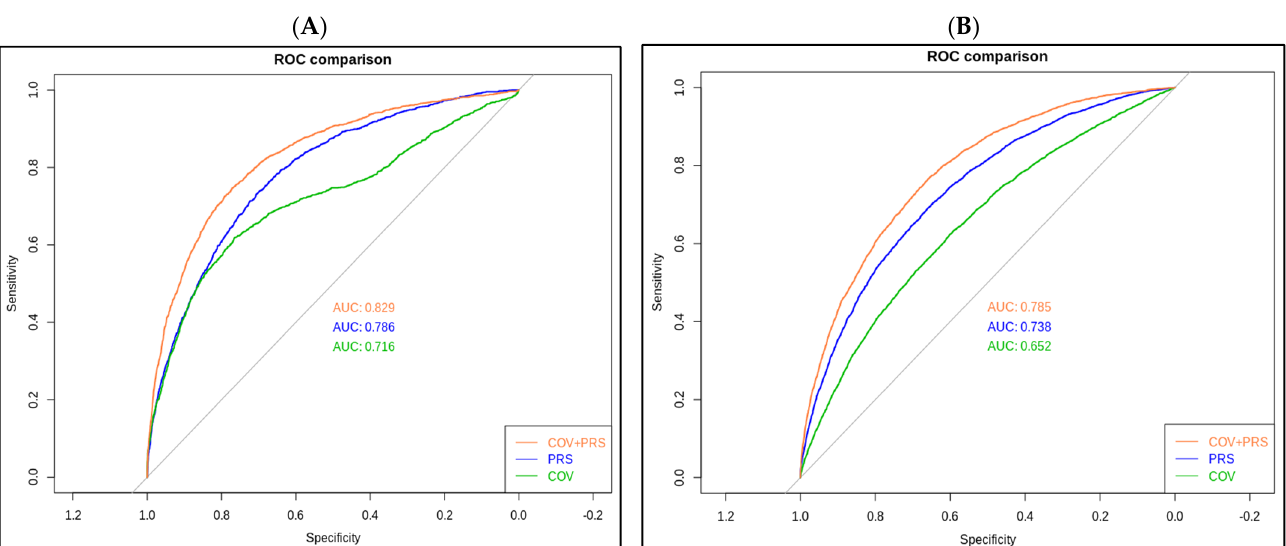
Figure 3. Receiver operating characteristic (ROC) curves for the polygenic risk score (PRS) model. ( A ) PRS_younger refers to younger cataract cases (<60), and ( B ) PRS_older refers to the older cataract cases ( ≥